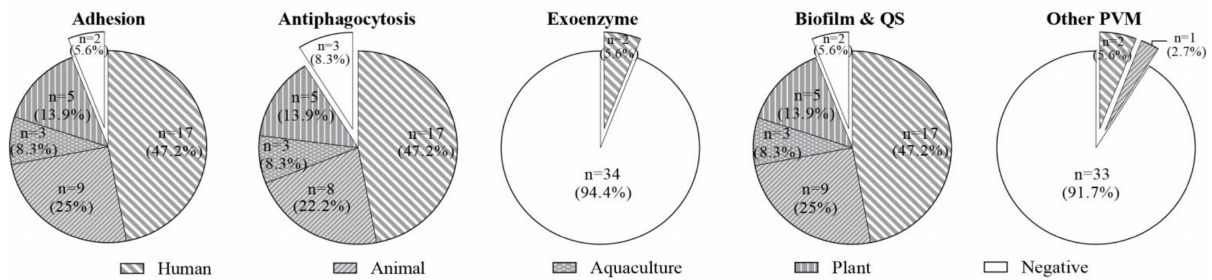
Figure 3. The virulence profile of 36 Enterococcus spp. isolates from four origins. The detection rates of virulence factors associated with adhesion, antiphagocytosis, exoenzyme, biofilm, and other PVM in 36 Enterococcus spp. were 94.4%, 91.7%, 5.6%, 94.4%, and 8.3%. In the above diagrams, negative indicates an isolate not carrying the corresponding virulence gene. Except for factors associated with exoenzymes merely detected in two probiotic E. faecalis from human products (5.6%), prevalence rates of factors associated with adhesion, antiphagocytosis, and biofilm in enterococci from human, aquaculture, and plant probiotics were 47.2%, 8.3%, and 13.9%, respectively, while these three factors in enterococci from animal probiotics were 25%, 22.2%, and